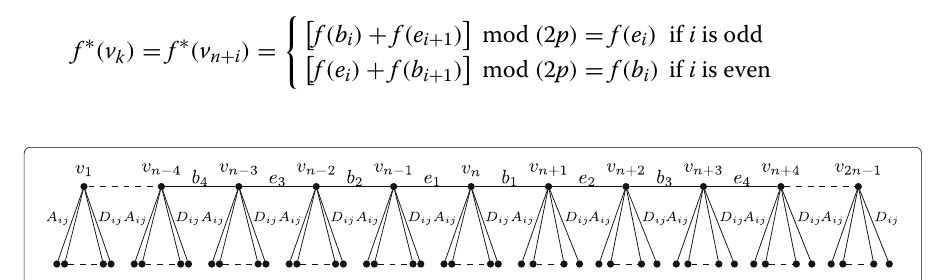
Fig. 8 P 2 n − 1 (cid:4) K 2 m with ordinary